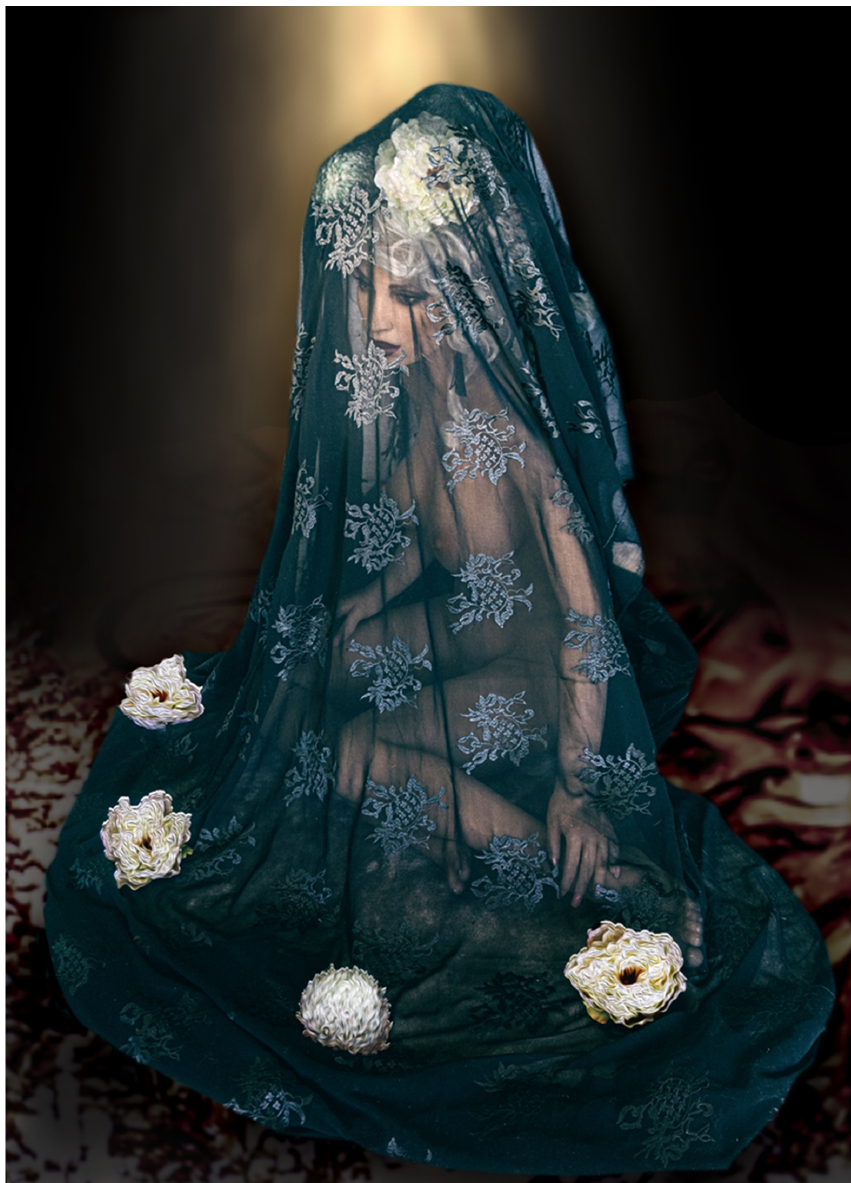
Figure 6. Madeleine + All true feeling is in reality untranslatable. By Graeme Revell, 2022. Photo- graph, GPT-2/DALL-E2 image and text.